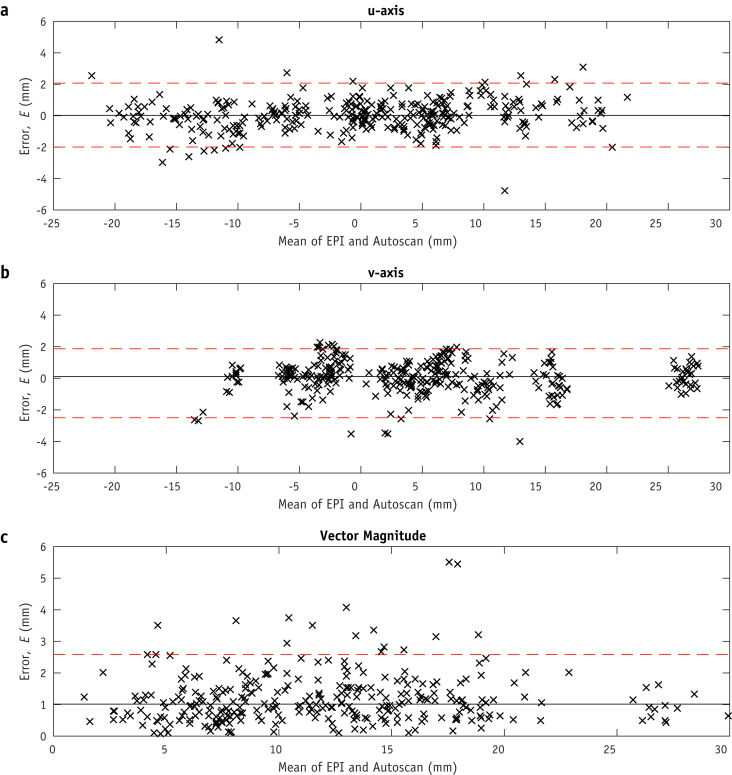
Bland-Altman plots of Autoscan error (E), depicted on the plots' y axes, as the difference between monitoring and electronic portal imaging (EPI) estimates of prostate position. Median E is shown by the solid line, and 95% limits of agreement (LOAs) are shown by the dashed lines: in the portal image horizontal u axis, with a median of 0 mm and 95% LOAs of –2.0 to 2.1 mm (a); vertical v axis, with a median of 0.1 mm and 95% LOAs of –2.5 to 1.9 mm (b); and Bland-Altman plot of the 2-dimensional error vector magnitude (u2+v2), with a median of 1.0 mm and 95% LOA of 2.6 mm (c).